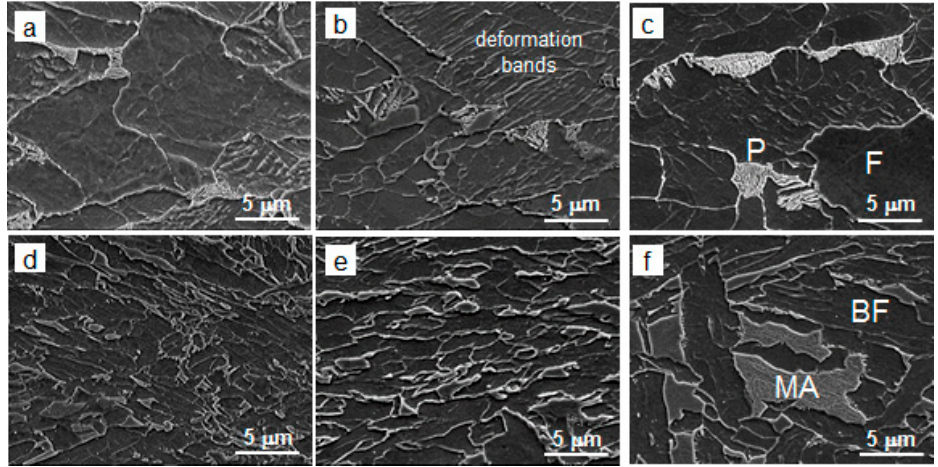
Figure 3. SEM images of microstructures in ( a – c ) Ti-steel and ( d – f ) MoNbTi-steel, after processing according to schedule ( a , d ) A, ( b e ) B and ( c , f ) C (Figure 1): P—pearlite, F—ferrite, M/A—martensite-austenite constituent, BF—bainitic ferrite.